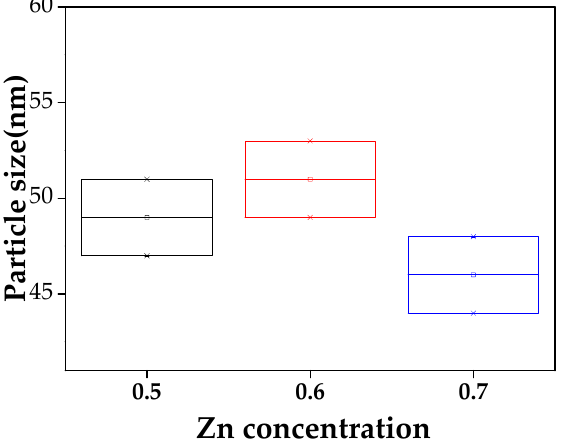
Figure 4. The dependence of the lattice parameters of the Ni 1 − x Zn x Fe 2 O 4 (x = 0.5, 0.6, 0.7) ferrite nanoparticles on the Zn concentration.